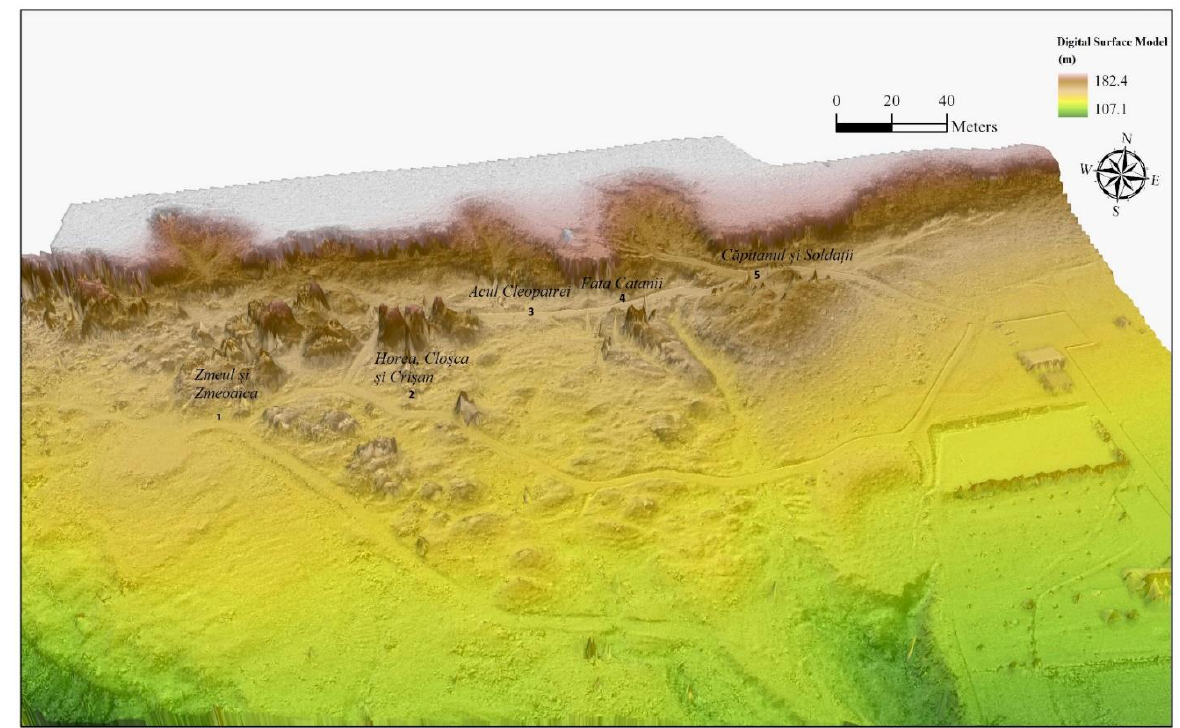
Figure 4. Digital surface model of the Grădina Zmeilor geomorphosite (where: 1 — Zmeul and Zmeoaica, 2 —Horea, Cloșca and Crișan, 3— Acul Cleopatrei, 4 —Fata Cătanei, 5—Căpitanul and Soldații) .